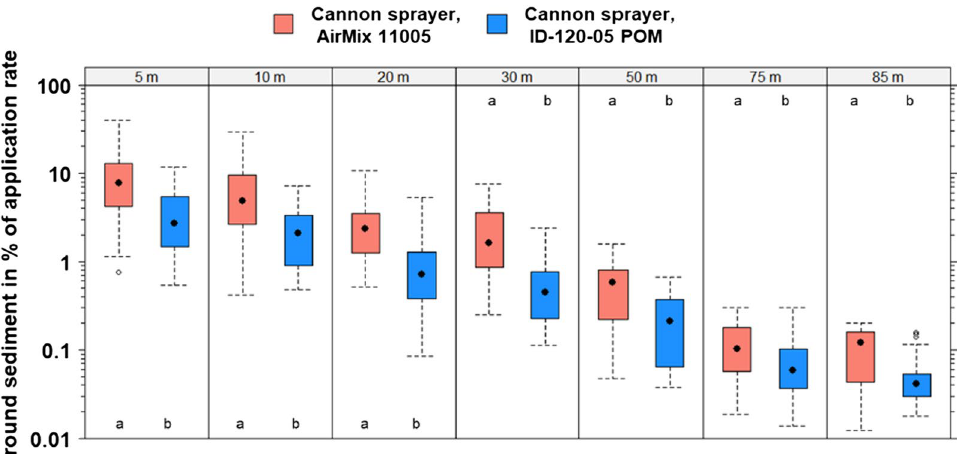
Fig. 3 Measured values of spray drift in percentage of application rate with a cannon sprayer using AirMix 110‑05 and ID‑120‑05 POM depending on the distance to the treated area. Different letters indicate significant differences between the techniques within the distance (median.test, α 0.05) =